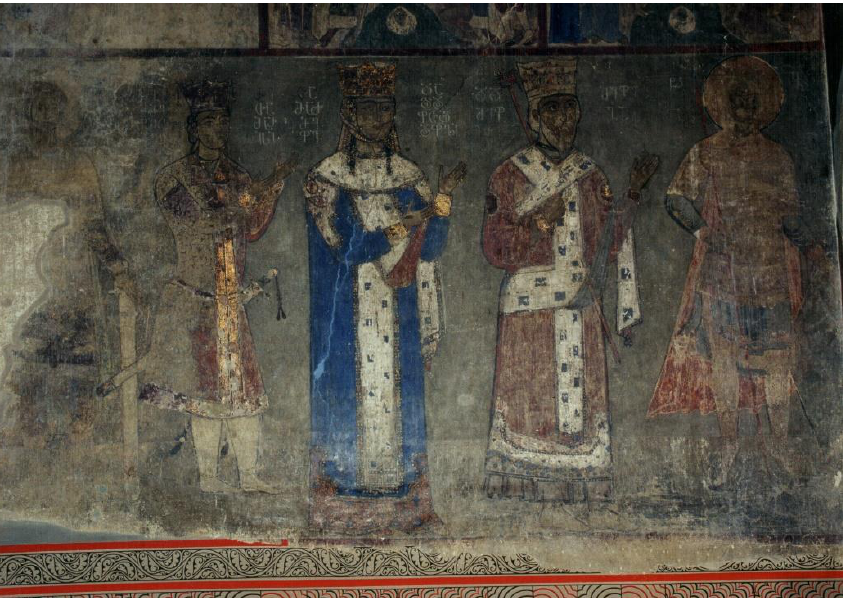
Figure 4. Queen T’amar alongside her deceased father Giorgi III and her heir co-monarch Lasha (f uture King Giorgi IV), fresco, after 1206/7, church of the Virgin at Bet’ania monastery (Photograph: Neli